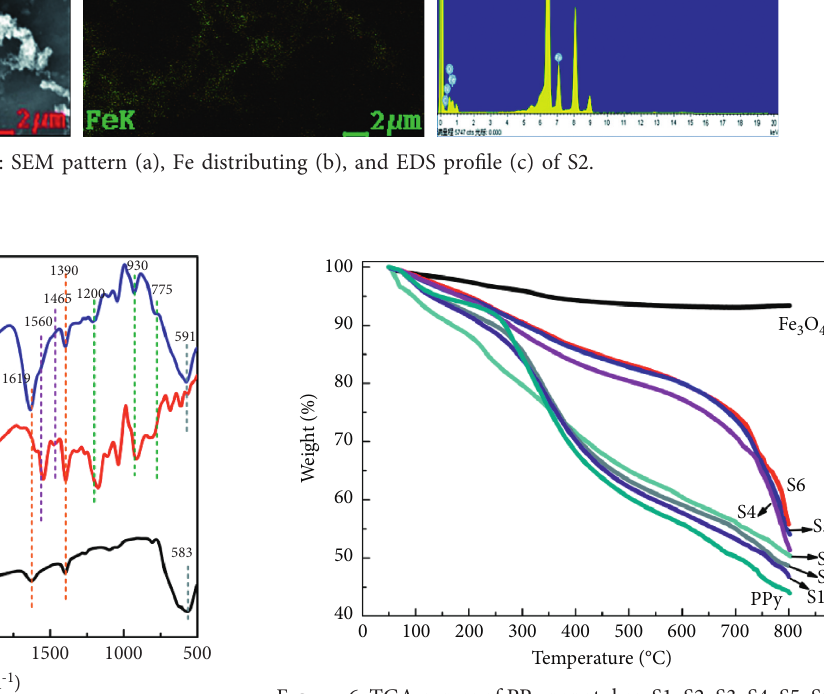
Figure 5: Fourier infrared spectrum of Fe (b), and Fe 3 O 4 /PPy nanotubes (c).